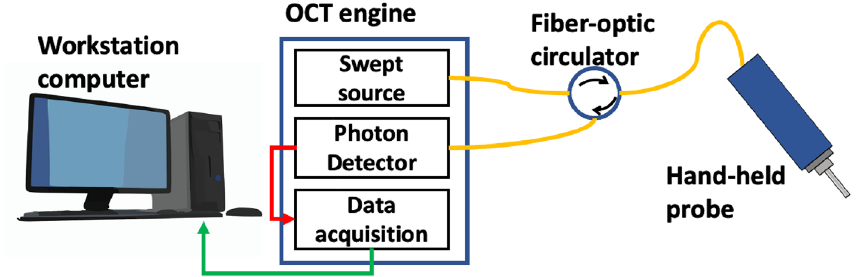
Figure 1. Schematic of manually scanned OCT imaging